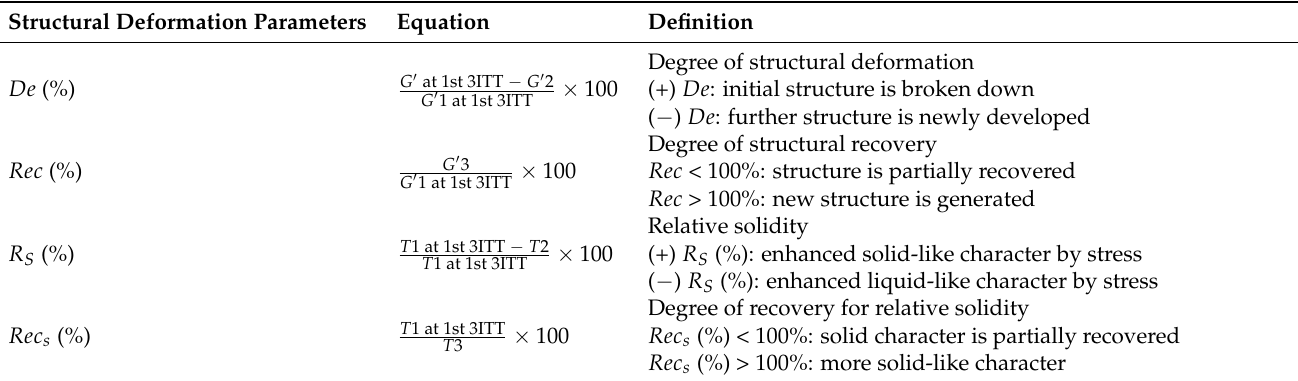
Table 1. Structural deformation parameters obtained from three-interval thixotropic tests (3ITTs) by varying the shear stresses applied to the Si anode slurries [39,41].